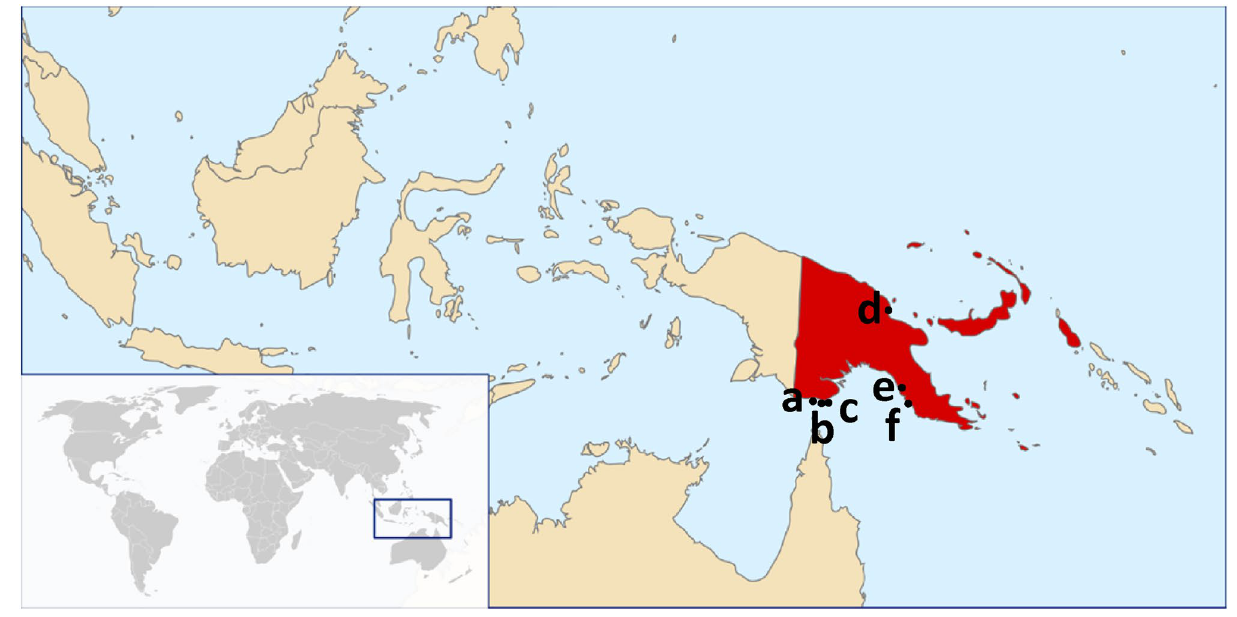
Figure 3. Collection locations of Bactrocera trivialis samples from Papua New Guinea and the Torres Strait Islands that were tested in this study; ( a ) Boigu Island; ( b ) Dauan Island; ( c ) Saibai Island; ( d ) Madang Province; ( e ) Central Province; and ( f ) National Capital District. Image adapted from Wikimedia Commons: Vardion, 2006, under the GNU Free Documentation License, Version